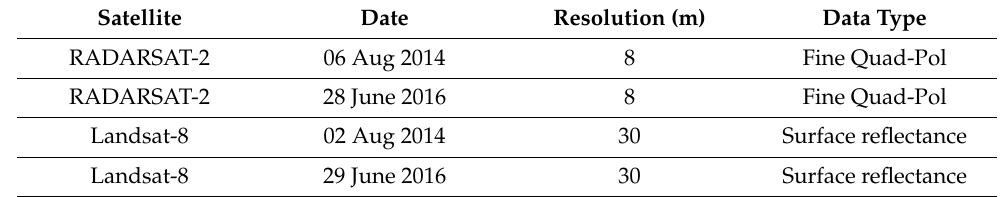
Figure 1. Study area. Panel ( a ) shows the true color image of the area with field sites in green (YERA present) and grey (YERA absent), panel ( b ) shows the elevation of the area, and panel ( c ) show the study area located in relation to the rest of western Canada. Table 1. List of images used for the analysis of the Yellow Rail habitat. Two RADARSAT-2 images were used for the 28 June 2016